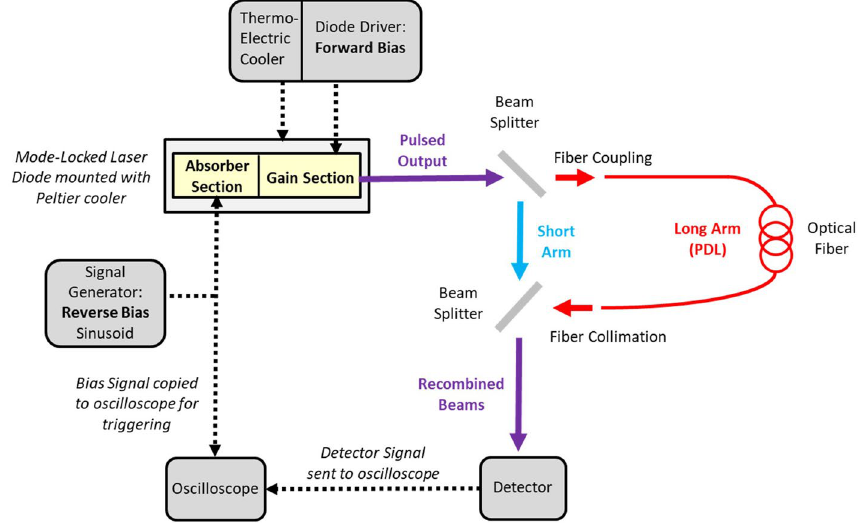
Figure 2. The OSBERT setup used to acquire cross-correlation traces at megahertz scan